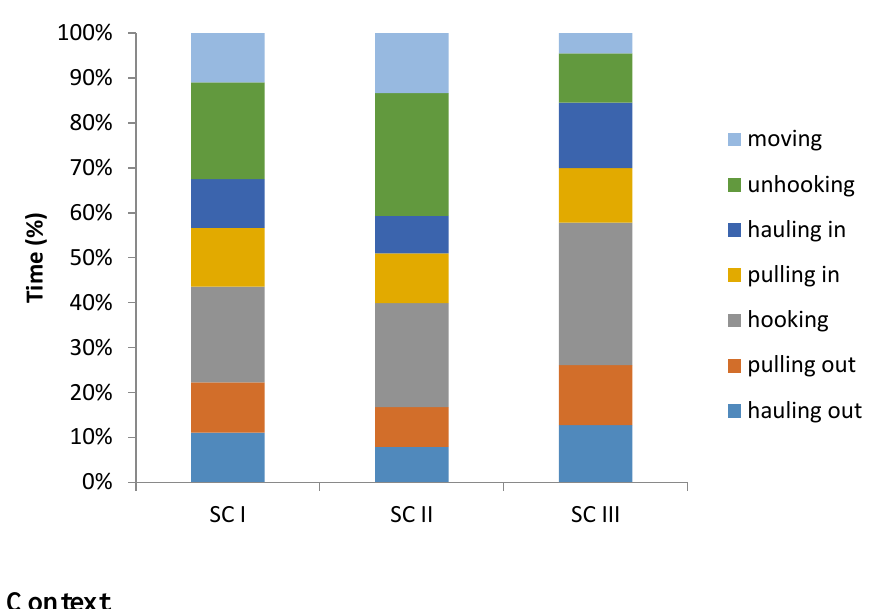
Figure 11. Proportional time of cable logging